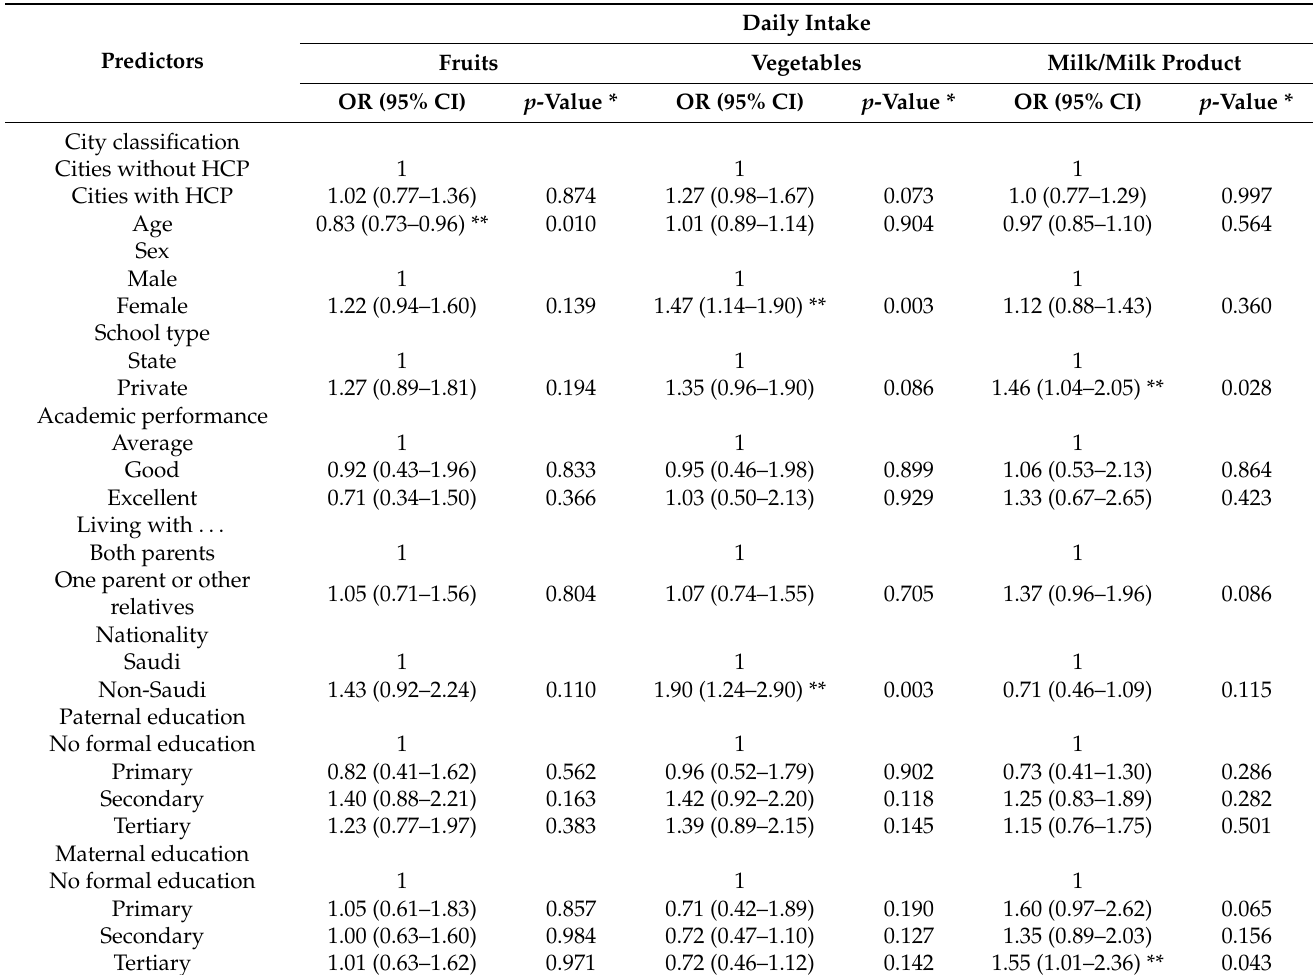
Table 4. Predictors of healthy food intake among adolescents in Qassim, Saudi